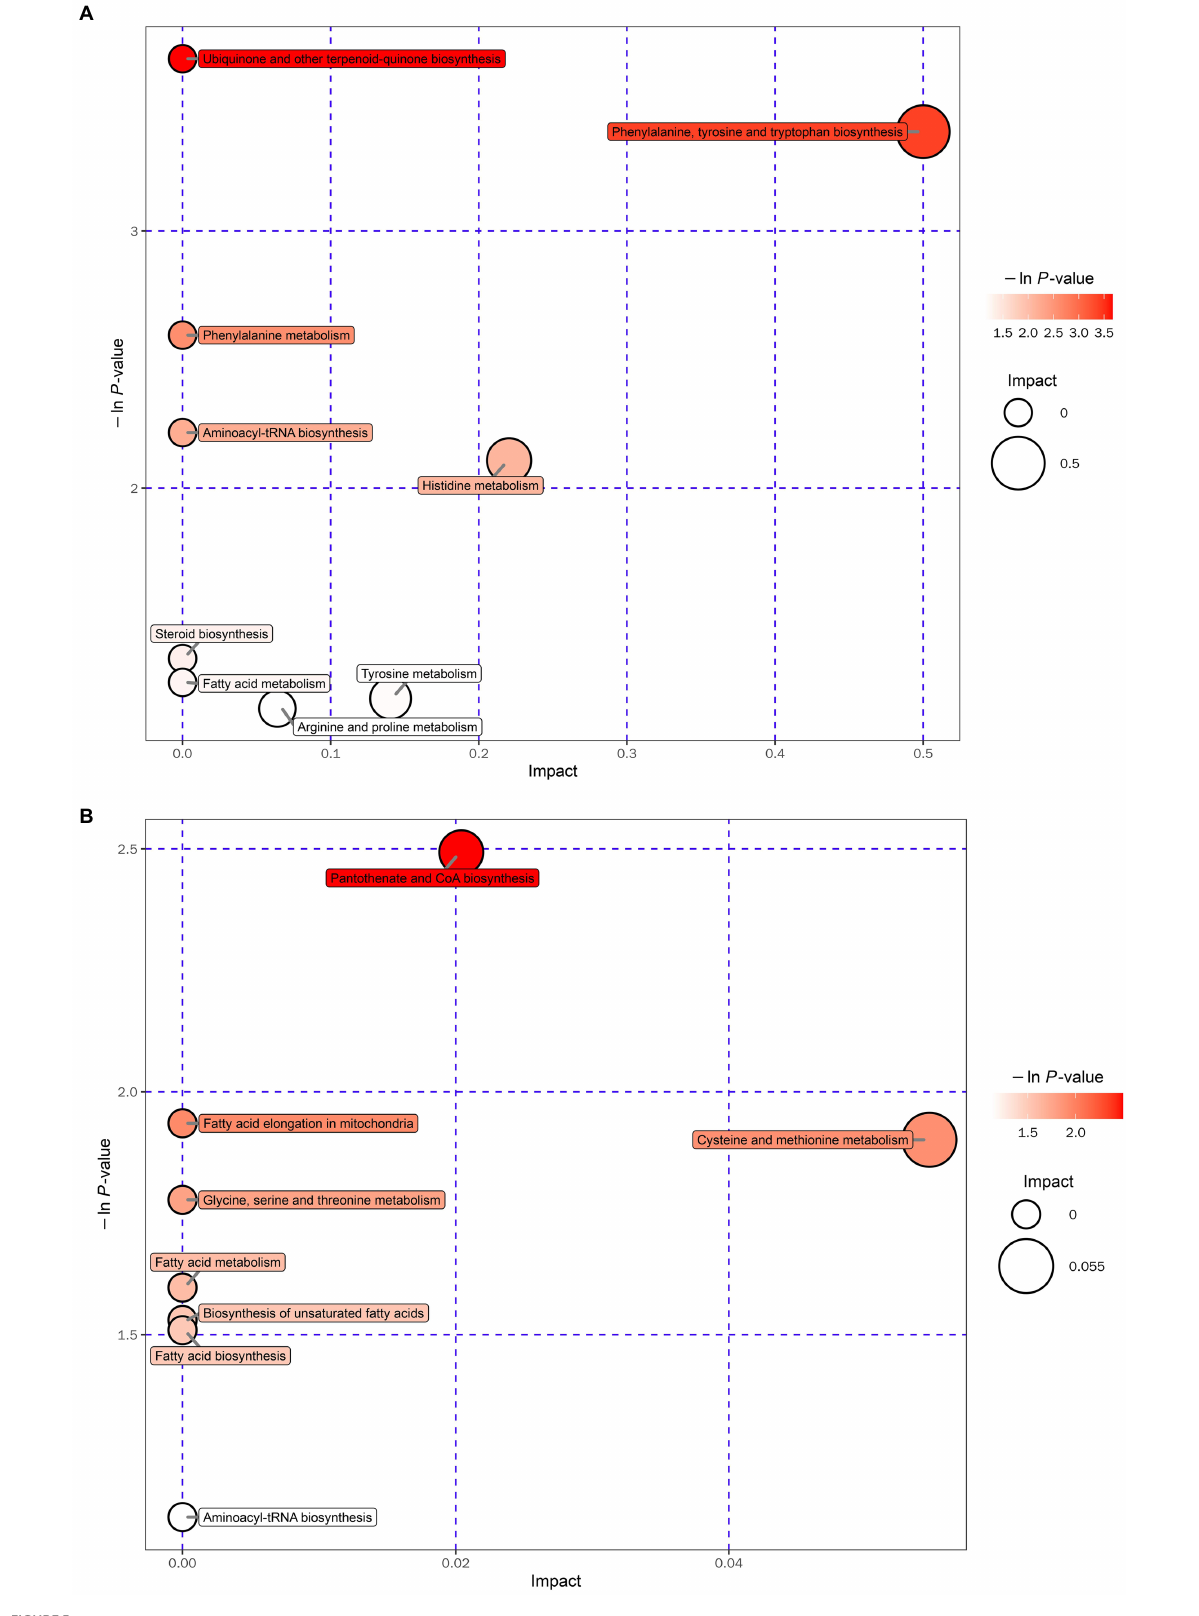
FIGURE 5 Bubble plot for the SHR and WKY groups ( A : positive ion mode. B : negative ion